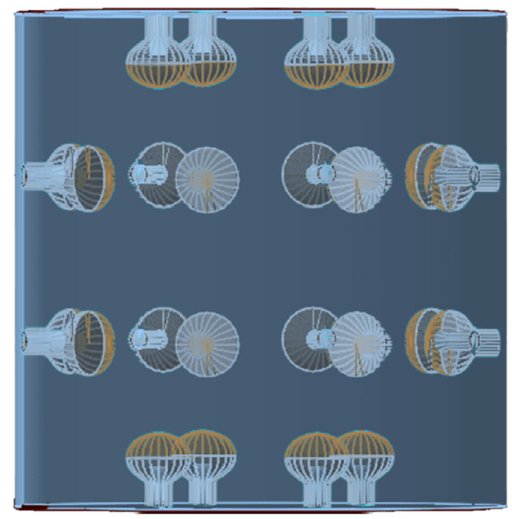
Fig. 2 Visualization of the detector and its inner PMTs using the RAT- PAC simulation framework